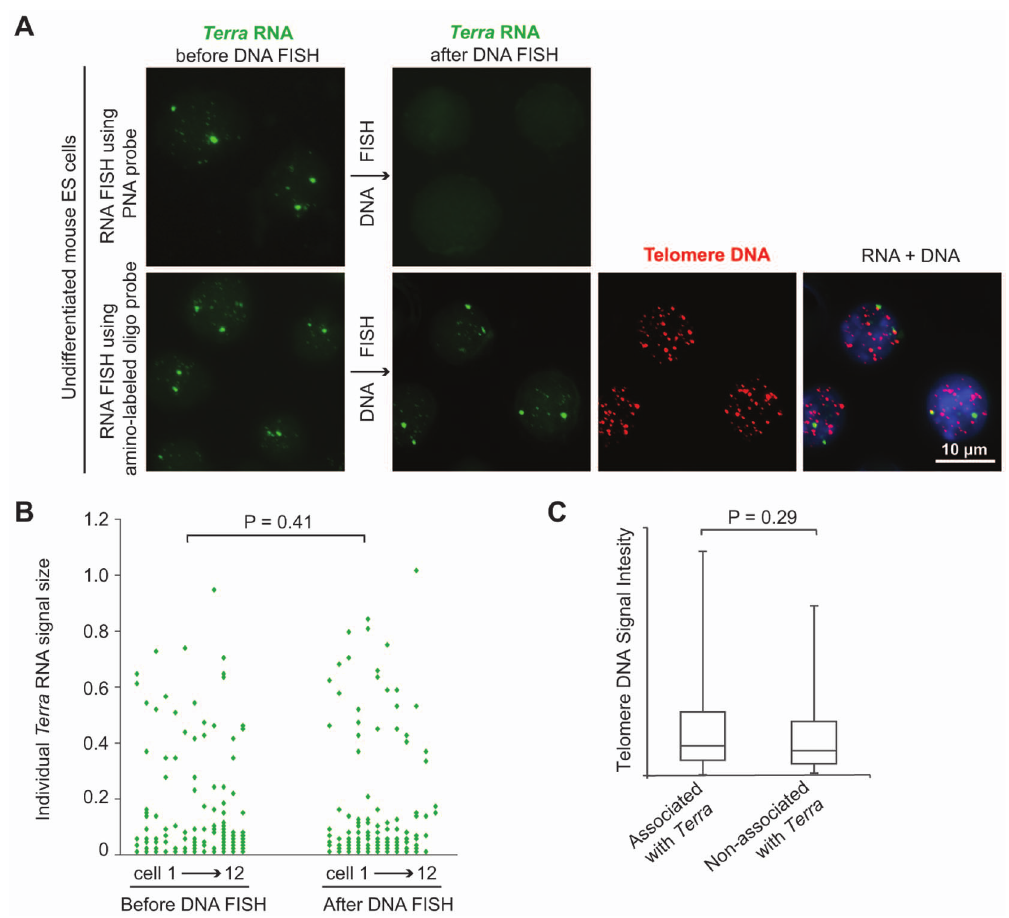
Figure 2. RNA-DNA FISH of Terra (RNA) and Telomere (DNA) using an amino-labeled oligonucleotide probe. (A) Either a FITC-labeled PNA probe (green) or an amino-labeled oligonucleotide probe (fluorescently labeled with FAM, green) was used to detect Terra in RNA FISH. Telomere DNA was detected by Cy3-labeled oligonucleotide probes (red) with the sequence of (GGGTTA) 6 . Nuclei were stained by DAPI (blue). (B) The Terra RNA signal number per nucleus and the signal sizes before and after DNA FISH were compared. A z-series of 3 m m thickness was collected. Images were deconvolved and merged. Individual Terra signals in each cell were computationally recognized by setting a fluorescence intensity threshold. The size of each Terra signal ( m m 2 ) was computed. Terra signals measured from one cell are plotted as discrete spots vertically at the x-axis. The P-value was calculated using Student t-test. (C) DNA FISH signal intensity of telomeres was measured to quantitate individual telomere length. The telomeres associated and non-associated with Terra were separated into two groups (n=100 for each group). The data was presented in box- and-whisker plots. The P-value was calculated using Student t-test.